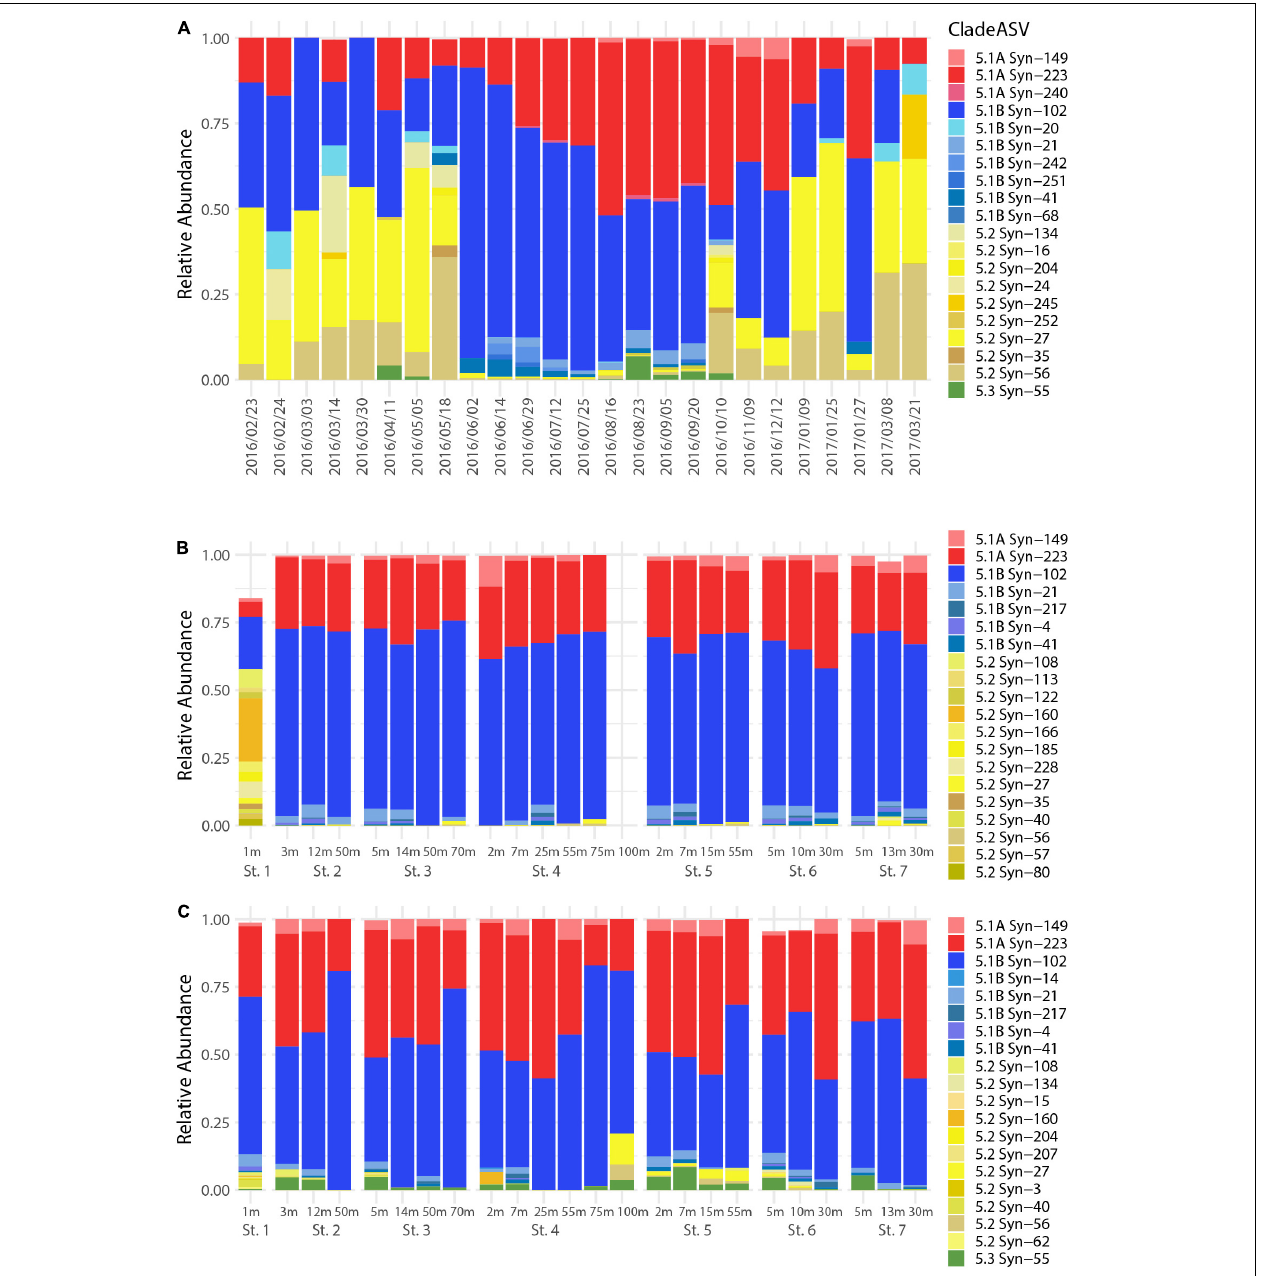
FIGURE 5 | Relative abundances and assigned subclusters depicting the top 20 most abundant Synechococcales ASVs in the (A) 2016–2017 time series, (B) summer transect (KB1707), and (C) fall transect (KB1709). ASVs are assigned to subclusters 5.1A (red), 5.1B (blue), 5.2 (yellow), and 5.3 (green). For (A) , each date indicates n = 1 libraries. For (B,C) at each station/depth, n = 2 averaged